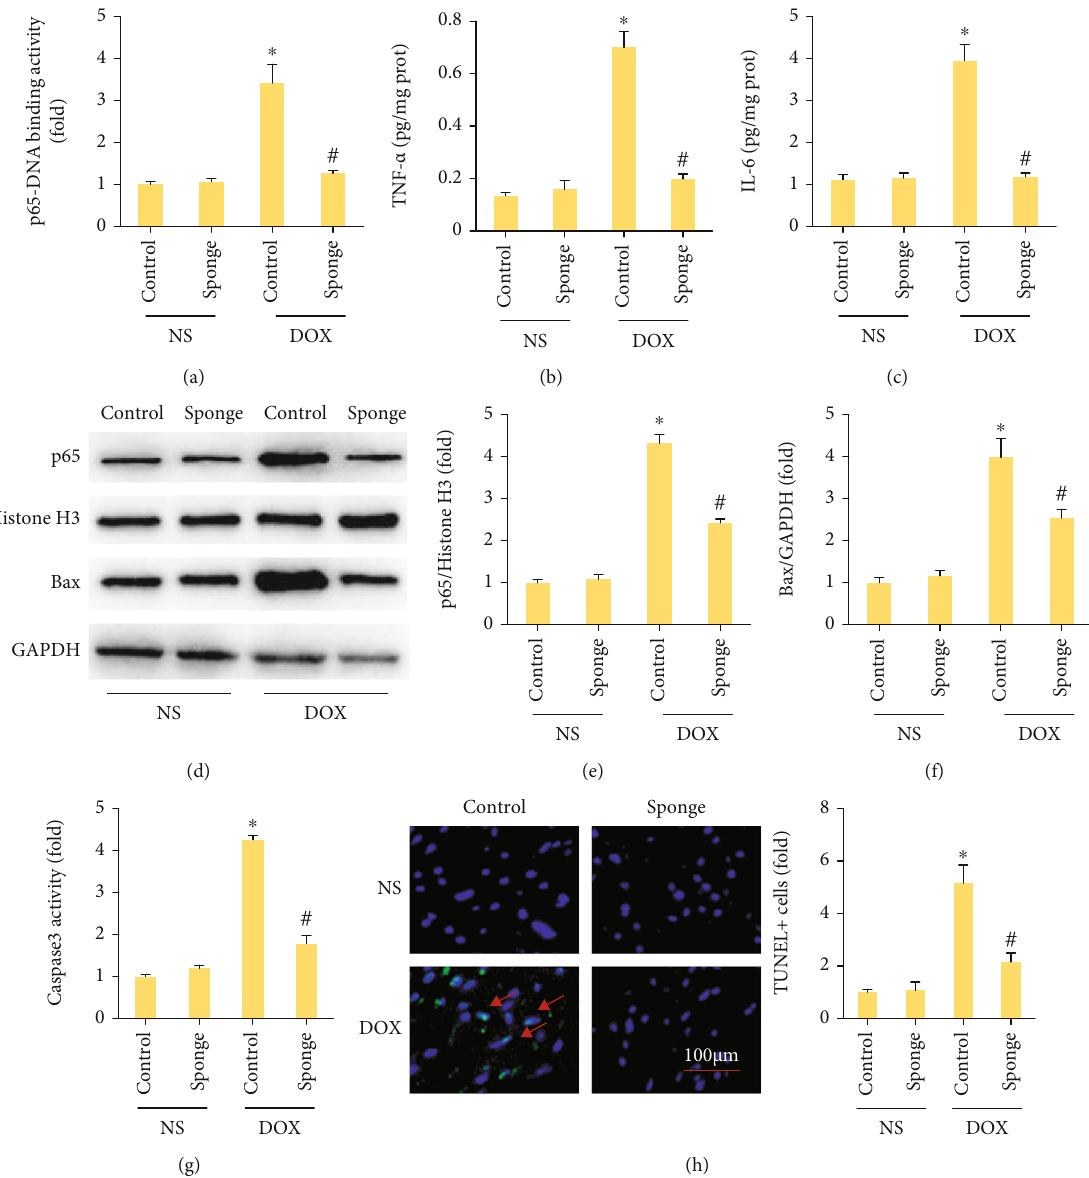
Figure 5: miR-128-3p inhibition attenuated in fl ammatory response in mice. (a) p65-DNA binding activity ( n = 6 ). (b, c) The levels of in fl ammatory factors in mice ( n = 6 ). (d – f) Western blot of Bax and nuclear p65 ( n = 6 ). (g) The caspase 3 activity ( n = 6 ). (h) TUNEL staining ( n = 6 ). Data are expressed as mean ± SEM . ∗ P < 0 : 05 vs. NS/control group; # P < 0 : 05 vs. DOX/control